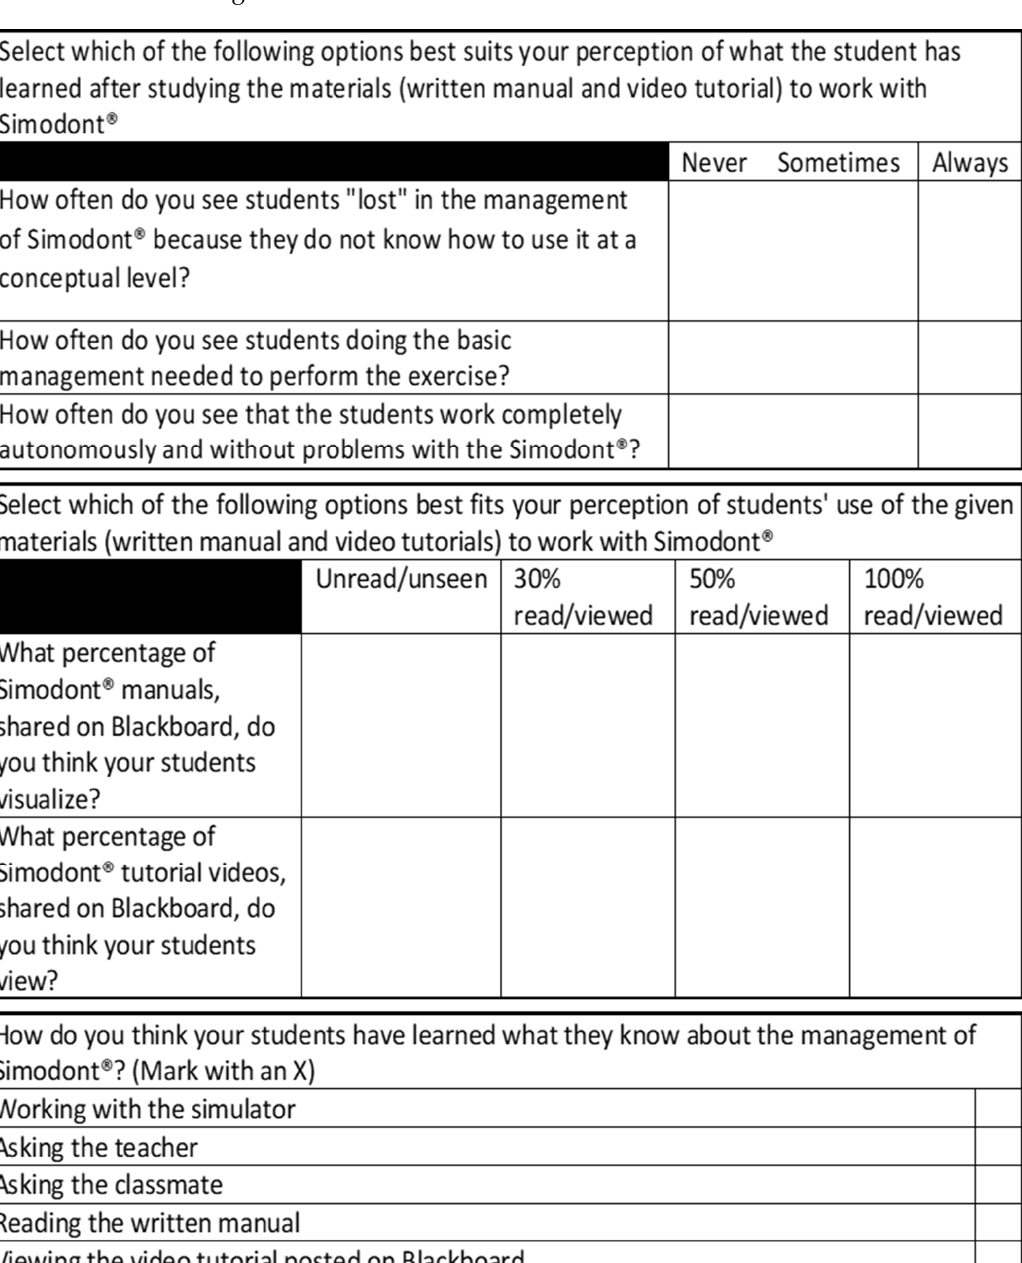
Figure 5. Questionnaire for teachers.